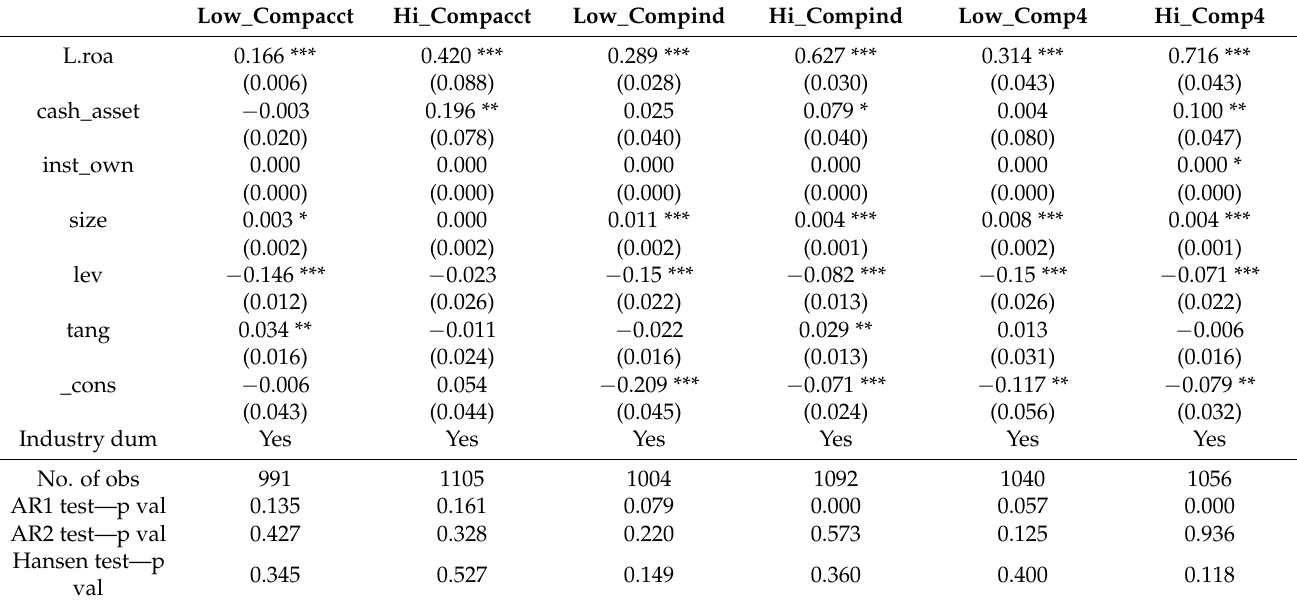
Table 5. Impact of cash on firm performance of samples based on comparability